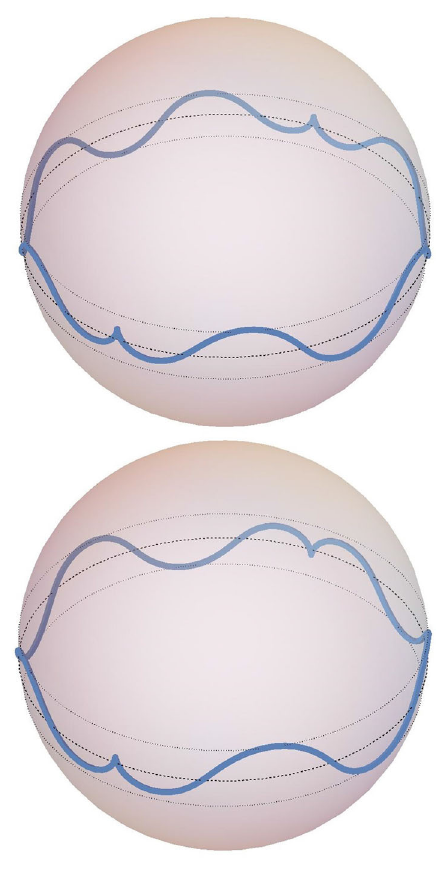
Fig. 13 Two closed string solutions with approximate periodicity con- ditions and n 2 = 2